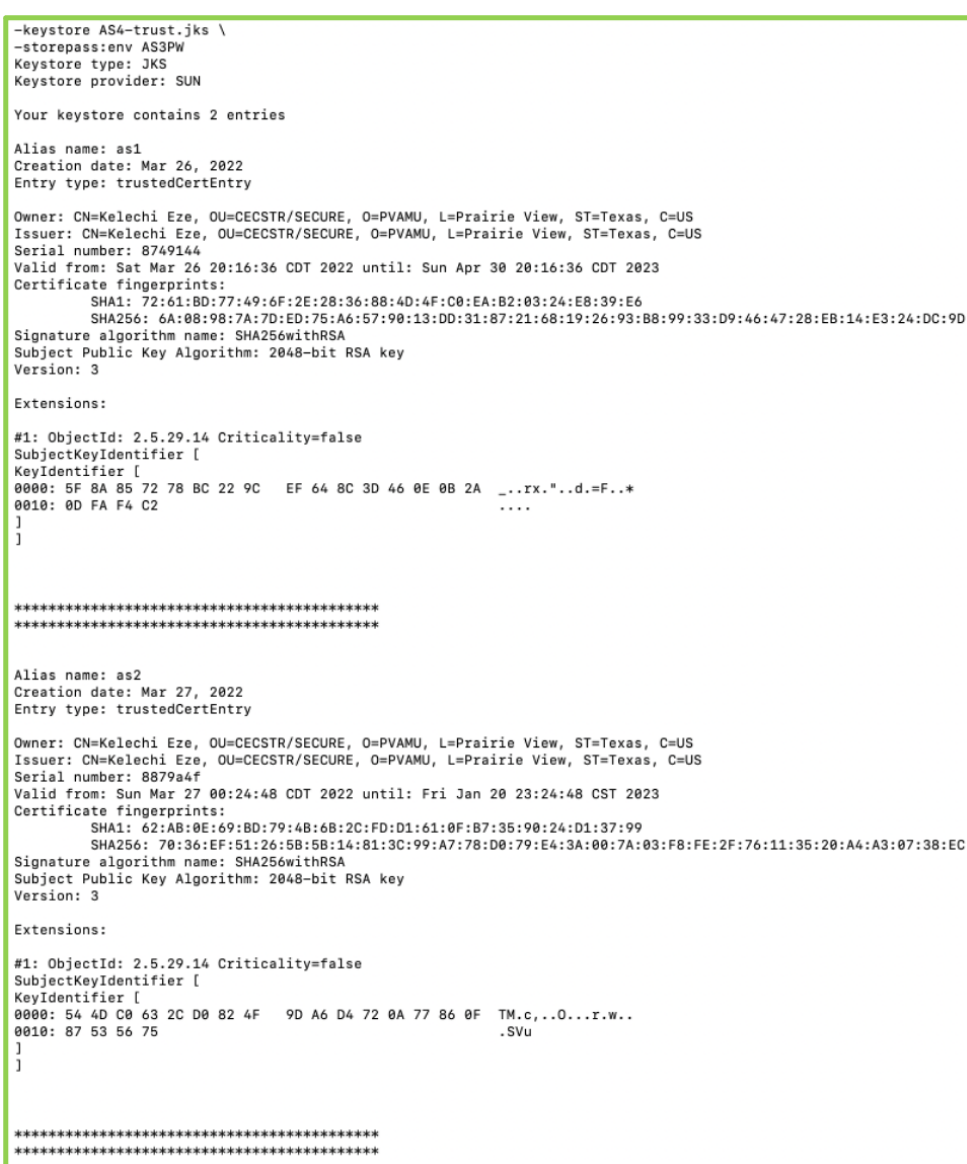
Figure 8. Public